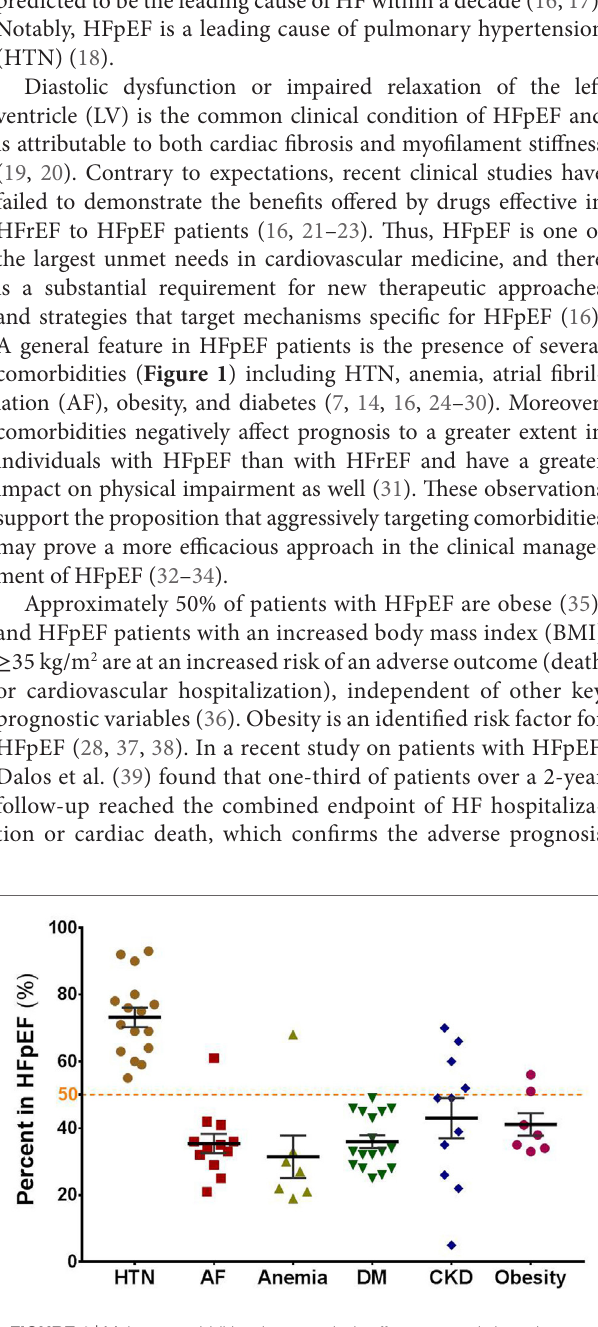
FiGURe 1 | Major comorbidities that negatively affect prognosis in patients with HFpEF. The graph shows the prevalence of comorbidities (in percent) in HFpEF patients enrolled in different clinical studies as summarized by Triposkiadis et al. (35): hypertension (HTN), atrial fibrillation (AF), anemia, diabetes mellitus or type II diabetes (DM), chronic kidney disease (CKD), obesity.